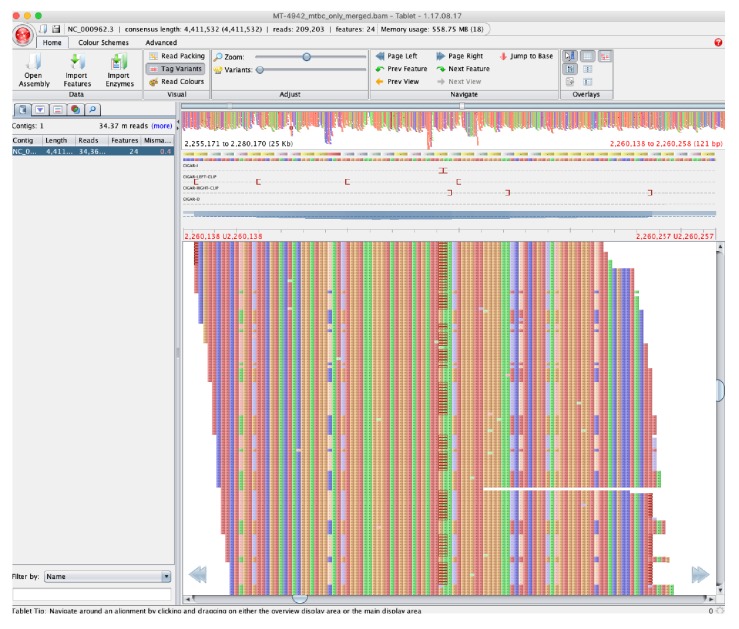
Pileup of reads showing hSNPs suspected to be due to alignment error as listed in Source data 3, with MT-4942 used as an example and zoomed on position 2,255,171 to 2,280,170 in H37Rv (National Center for Biotechnology Information RefSeq Database Accession NC_000962.3).Binary Alignment Map (BAM) file were loaded into Tablet (v.1.17.08.17, Milne et al., 2013) to visualize the pileup compared to H37Rv.